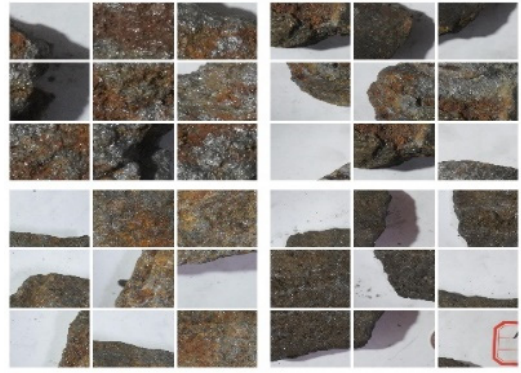
Figure 4. Image after cu tt ing (part).